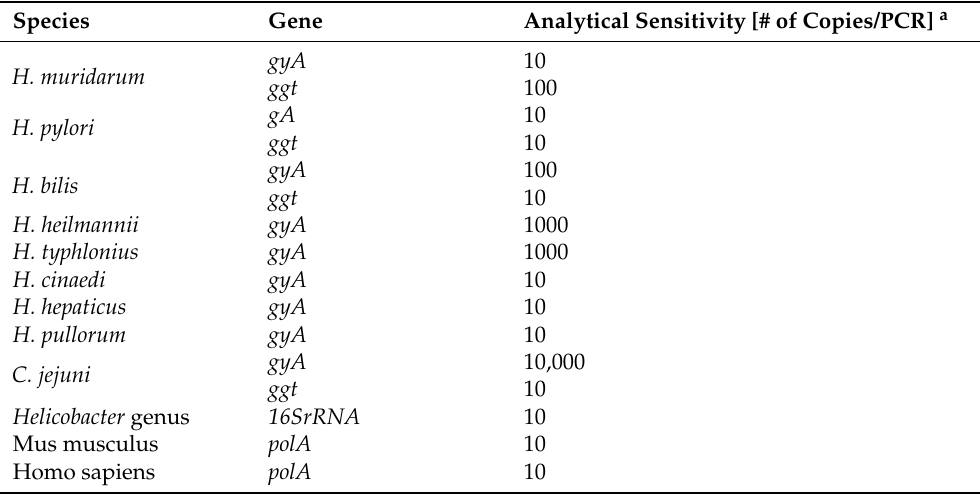
Table 3. Analytical sensitivity of Helicobacter multiplex DNA finder.